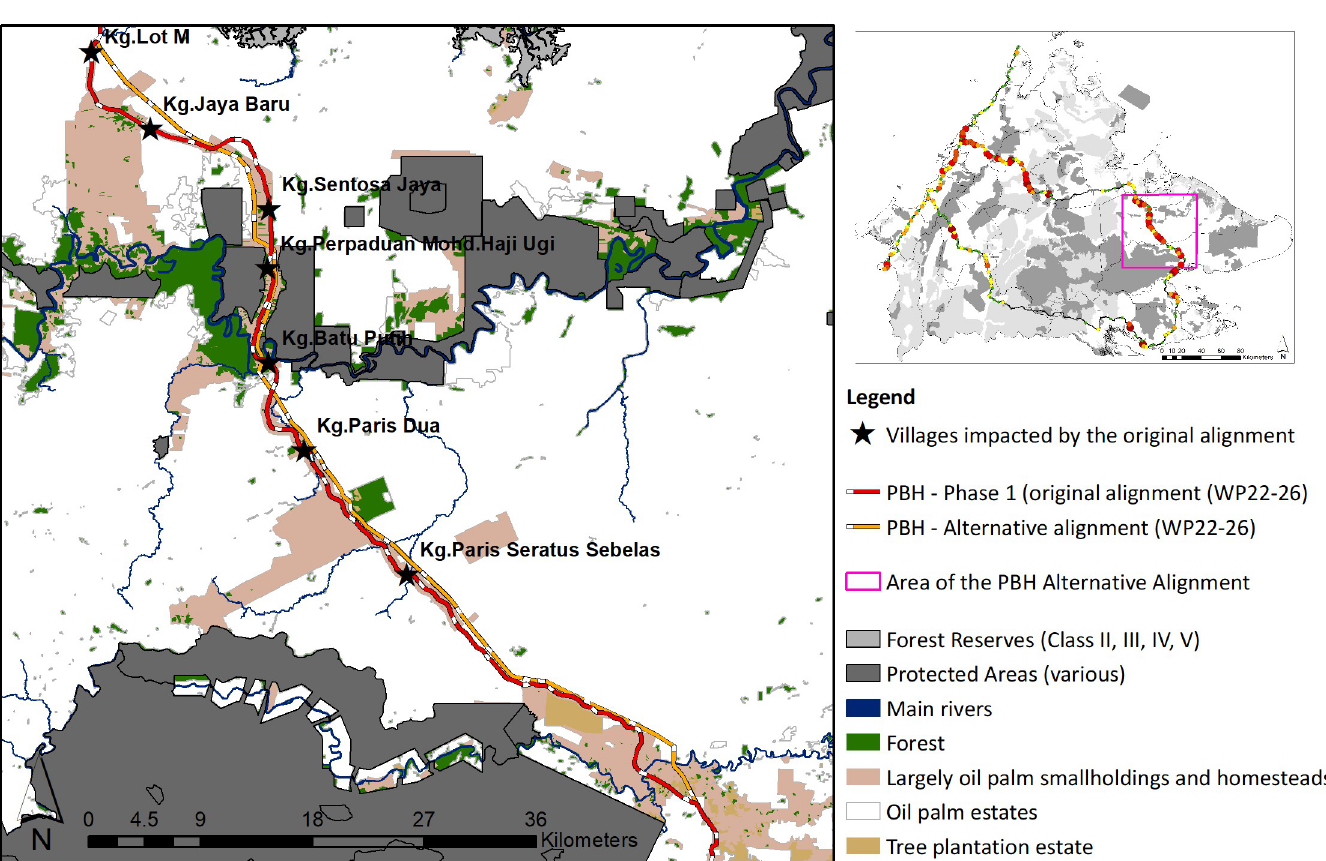
Fig 3. Alternative alignment for the Pan Borneo Highway. Top right map shows the area of the Pan Borneo Highway (PBH) alternative alignment within Sabah (pink box). The map on the left shows this area with the PBH’s original alignment (red and white line) and an alternative lower impact alignment (orange and white line) along with large areas of oil palm estates (white), protected areas/forest reserves (dark grey and light grey), unprotected forest (dark green), and community lands (largely Native titles) that contain homesteads and oil palm smallholdings (light pink) and village locations (yellow stars) and names.